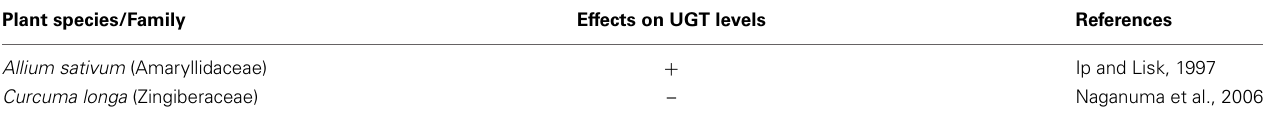
Table 8 | Medicinal plant species listed in RENISUS with reported effects of on UGT levels. Plant species/Family